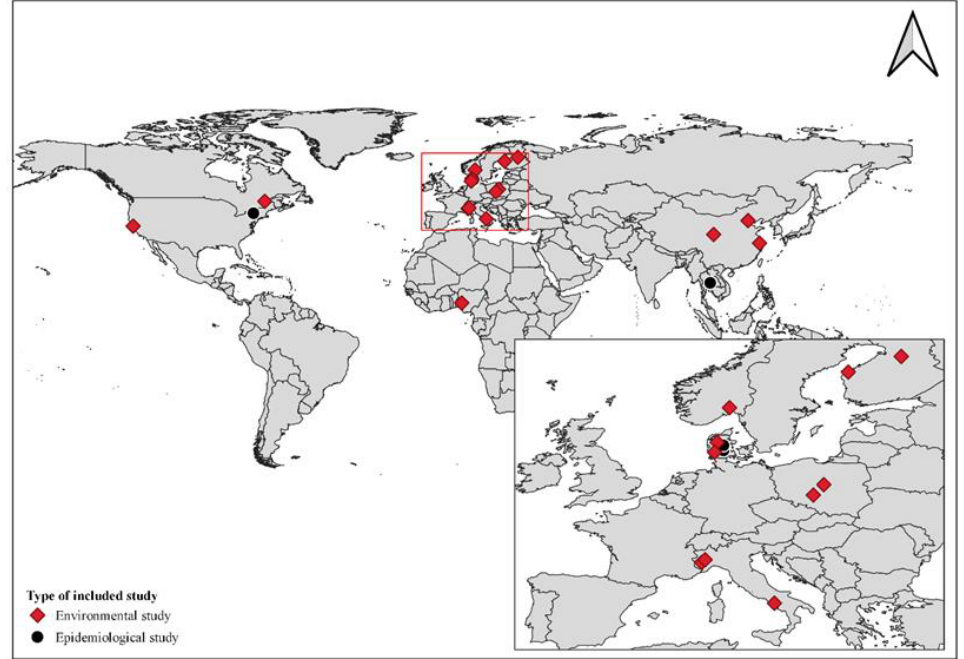
Figure 3. Geographical distribution of the selected studies around the world and in the European countries. Red diamonds: environmental studies; black dots: epidemiological studies.